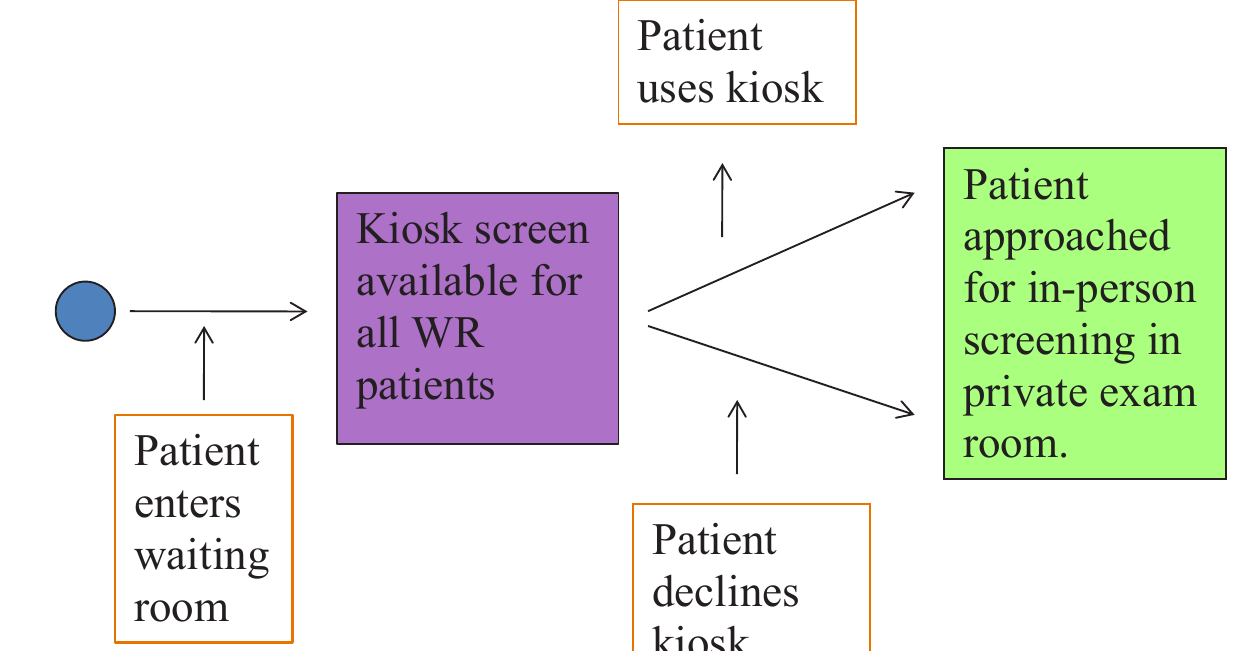
Figure 1. Patient flow diagram of participation in alcohol and drug use screening, using kiosk and in-person modalities. WR, waiting